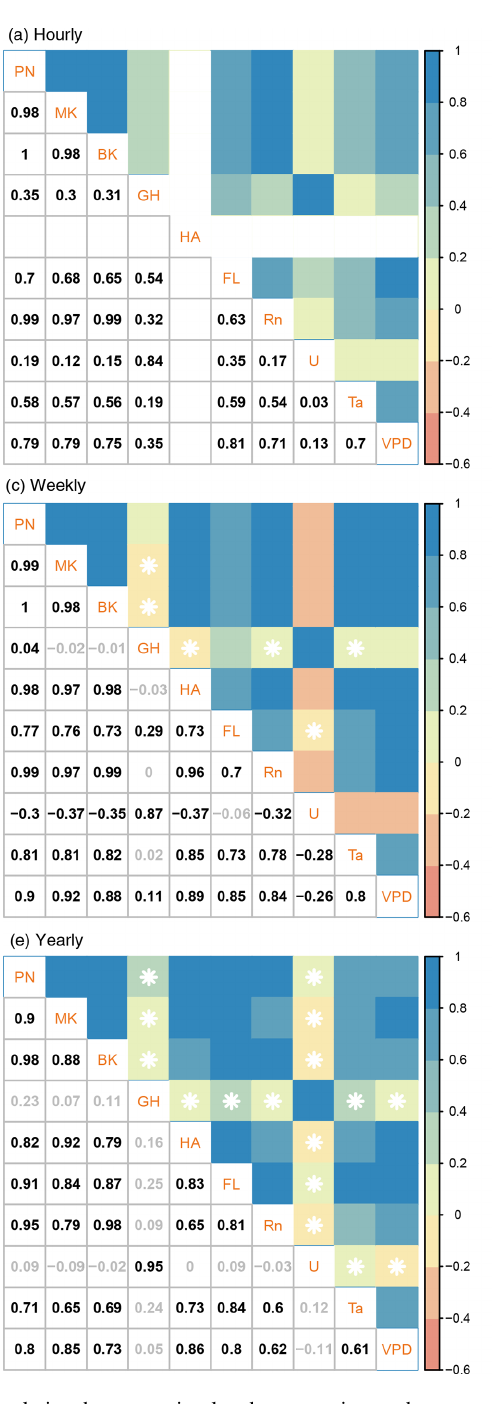
Figure 8. Correlation between simulated evaporation and meteorological variables at different timescales. Correlations are shown for (a) hourly, (b) daily, (c) weekly, (d) monthly, (e) yearly, and (f) 10-yearly timescales. The colours indicate the sign and strength of the correlation. A white star and the corresponding grey number mark insignificant correlations ( α = 0 .